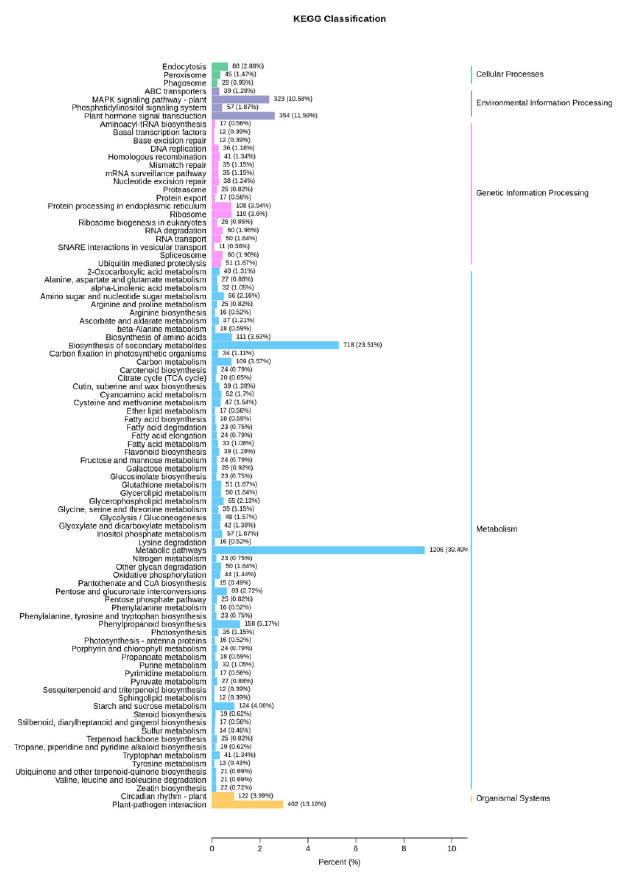
Figure 5. Differentially expressed genes divided into five different pathways based on Kyoto Ency- clopedia of Genes and Genomes (KEGG).